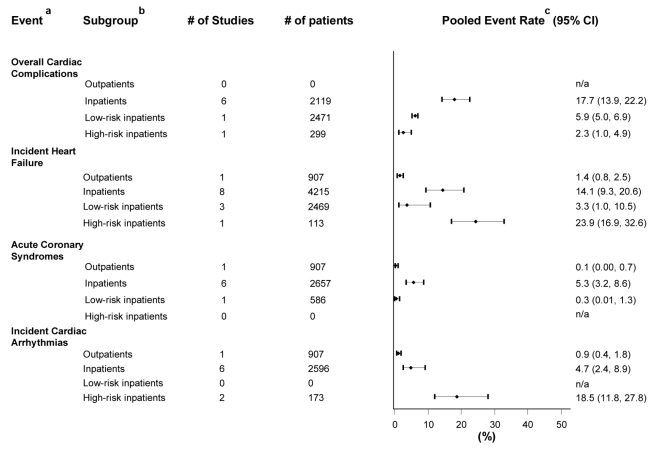
Pooled rates of the incidence of cardiac complications in patients with CAP.One study reporting the incidence of ACS and incident cardiac arrhythmias on outpatients and low-risk inpatients without making distinction between them was not included in the calculations of pooled rates [15]. aFor definitions refer to Table 1. bLow-risk inpatients included studies of inpatients with no indication for hospital admission, pneumonia severity index (PSI) risk-classes I–II, not initially admitted to intensive care units or who survived the first 48 h of hospitalization. High-risk inpatients included patients admitted to intensive care units. cWhen only one study was available, the reported rate represents the study event rate.